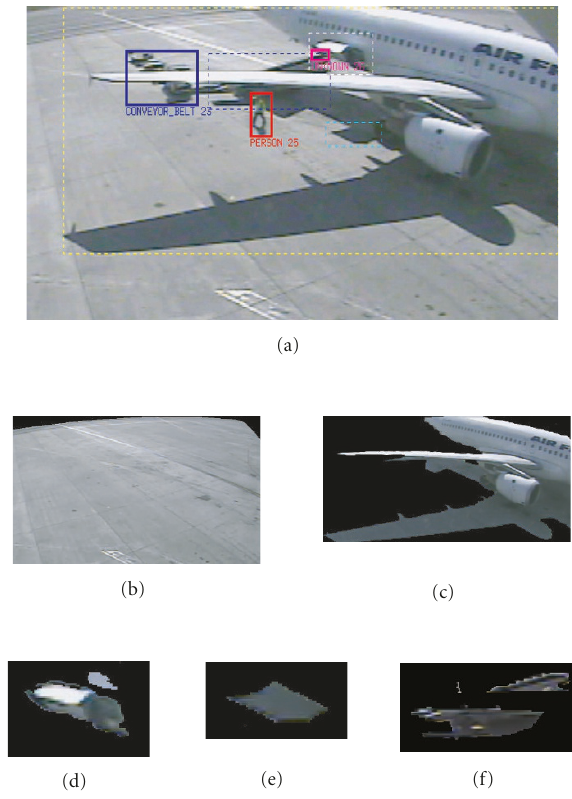
Figure 7: (a) Frame 2352 of sequence S3-A320 showing overlap- ping stationary and moving objects. The bounding boxes of sta- tionary objects are shown as dotted lines; for moving objects, their bounding boxes consist of solid lines. (b) The basic (full image) background layer. Other background layers (in order of creation) representing stationary objects: (c) the aircraft, (d) aircraft door, (e) aircraft door shadow, and (f) partially visible conveyor-belt